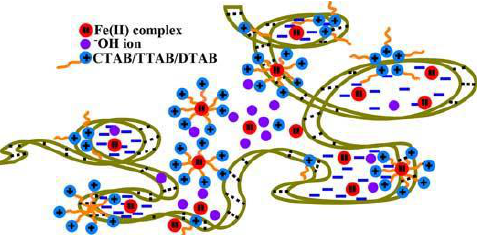
Figure 9. Cartoon showing the positioning of reactant species on guar-gum segments in gum aqueous solution. Figure adapted with permission from reference [98]. Copyright 2018 Taylor & Francis.